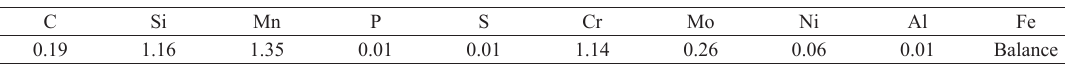
Fig. 1. Optical micrograph of a DIN 18MnCrSiMo6-4 continuous cooling bainitic steel. Table 1. Chemical composition of the DIN 18MnCrSiMo6-4 (wt.-%).